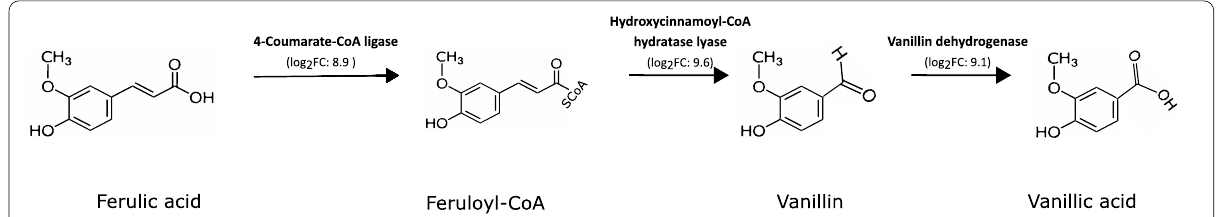
Fig. 4 In this study proposed bioconversion pathway of ferulic acid to vanillic acid for P. aromaticivorans AR20-38 based on the differentially expressed genes. The chemical structures of ferulic acid, feruloyl CoA, vanillin and vanillic acid are depicted. Putative involved enzymes and their log 2 FC values are shown above the